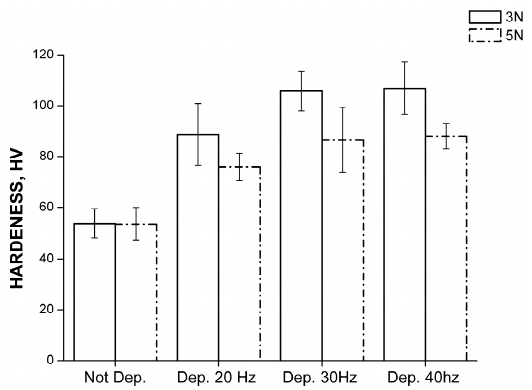
Figure 11. Hardness value obtained as a function of the indenter load and deposition frequency.